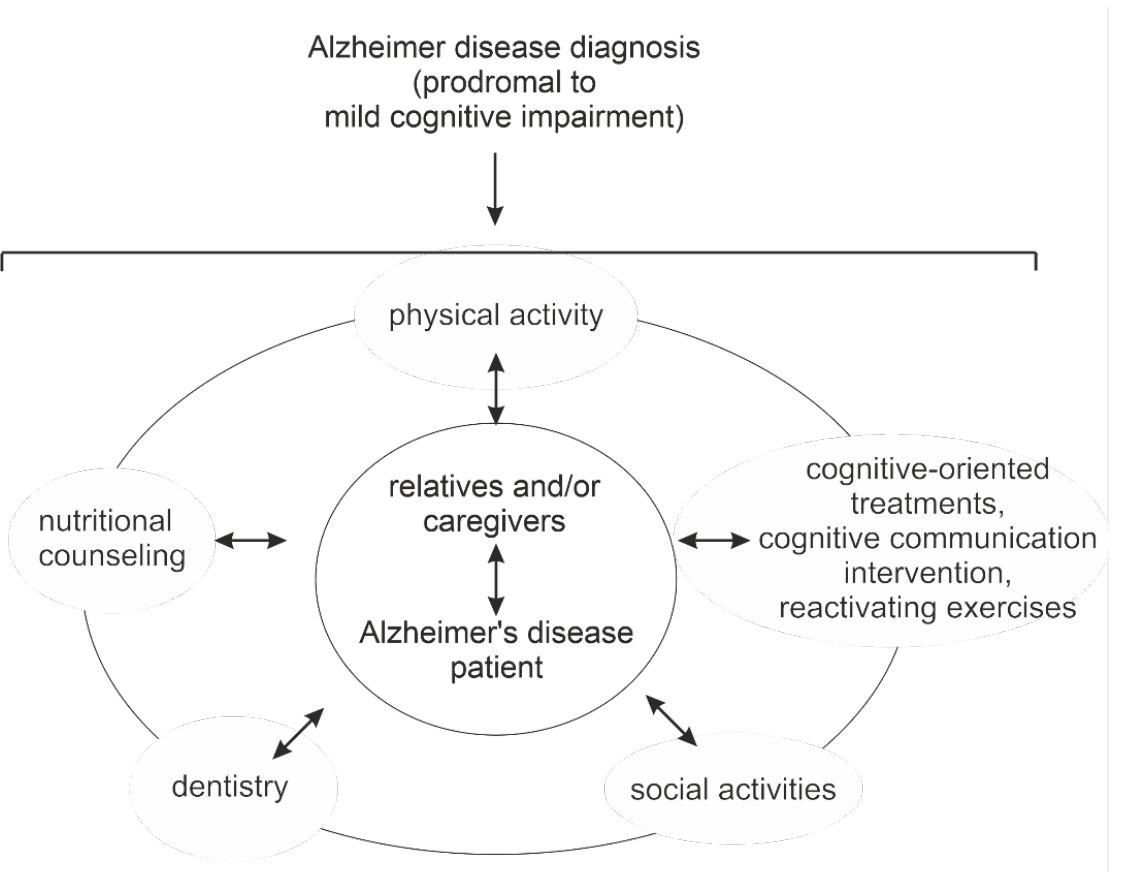
Figure 6. Schematic overview of the interrelationships and interactions of individual interventions in Alzheimer’s disease.